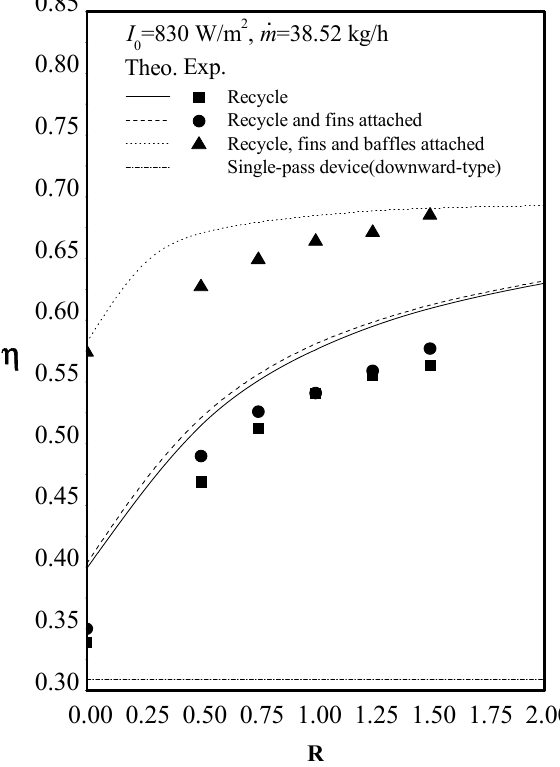
Figure 4. Effect of recycle ratio on collector efficiency in a double-pass flat-plate solar air heater with recycle; I = 830 W/m 2 , m  = 38.52 kg/h. 0